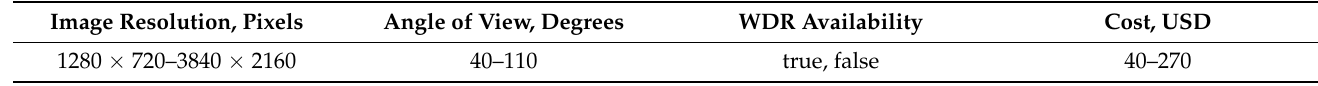
Table 4. Camera parameters in